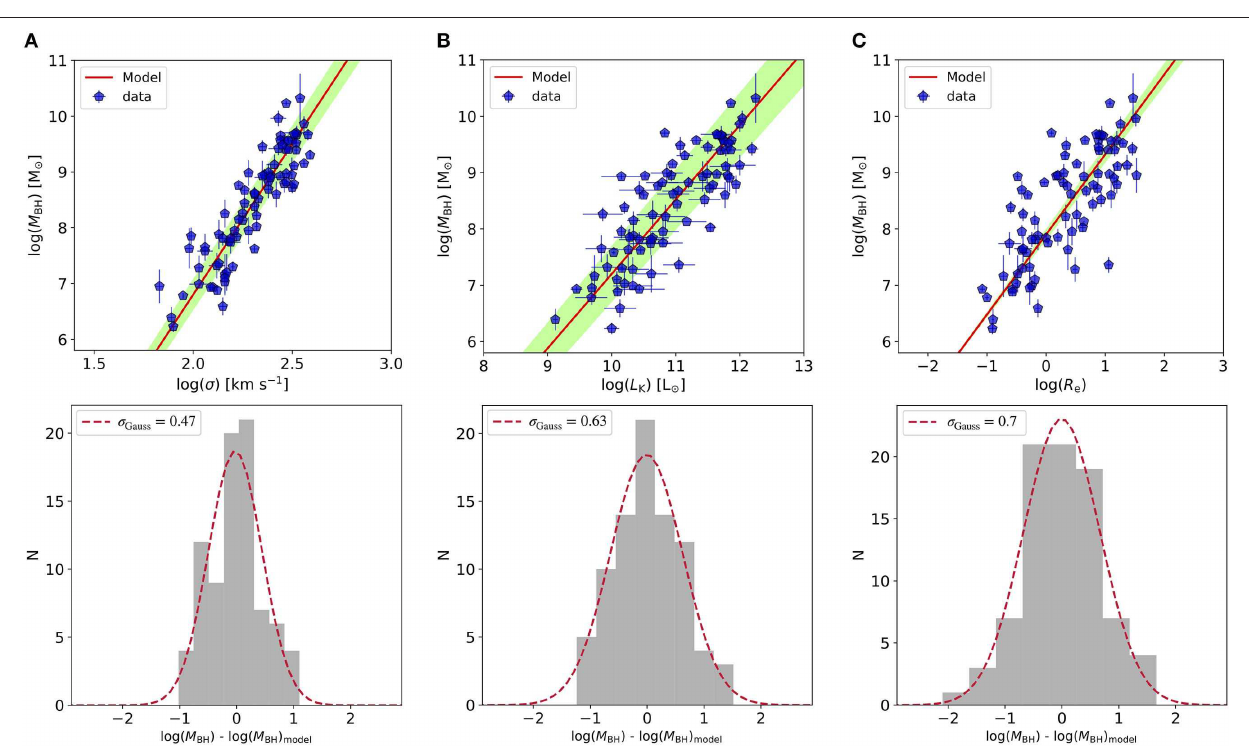
FIGURE 5 | Upper panels: a comparison between observations (blue points) and the 2D-space PCA model predictions (red lines) of the M BH - σ e (A) , M BH - L k (B) , and M BH - R e (C) relations is shown. The green shaded regions represent the scatters on the model relations. Lower panels: the distributions of the residuals are shown (gray histograms), along with their Gaussian fits (red dashed